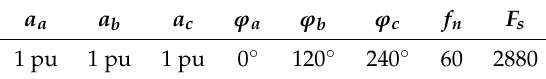
Table 1. Three-phase signal